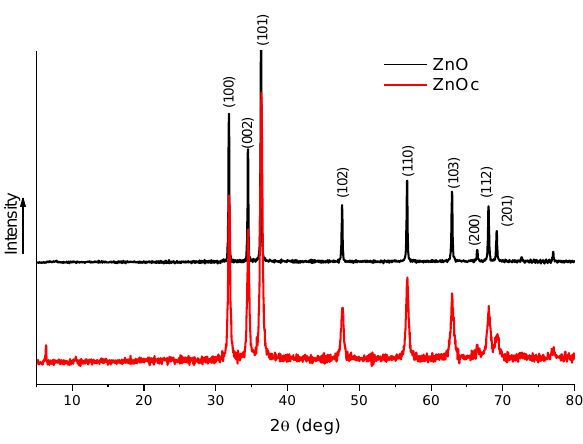
Figure 2. X-ray diffraction pattern of ZnO and ZnOc particles.